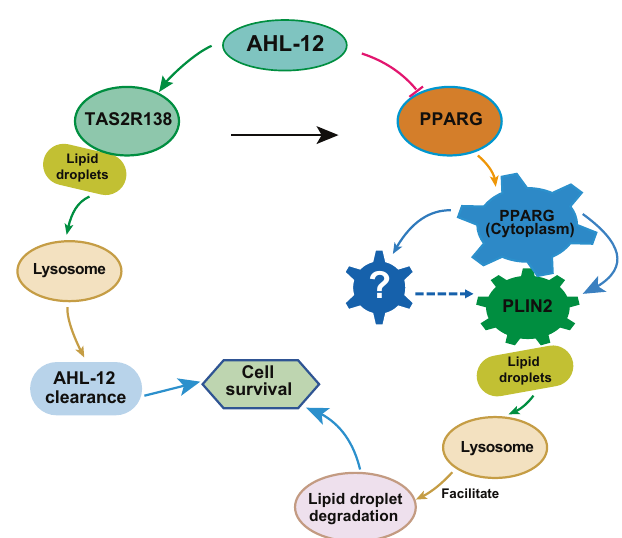
Fig. 7 Schematic diagram of TAS2R138 involved lipid droplet degradation pathway. During P. aeruginosa infection, TAS2R138 competitively conjugated with PPARG antagonist AHL-12. The released PPARG redistributes from nuclear to cytoplasm to accel- erate LDs degradation via binding with PLIN2. TAS2R138 binding with AHL-12 is associated with LDs, which is degraded during infection, thus helped the clearance of AHL-12 in neutrophils and promoting cell